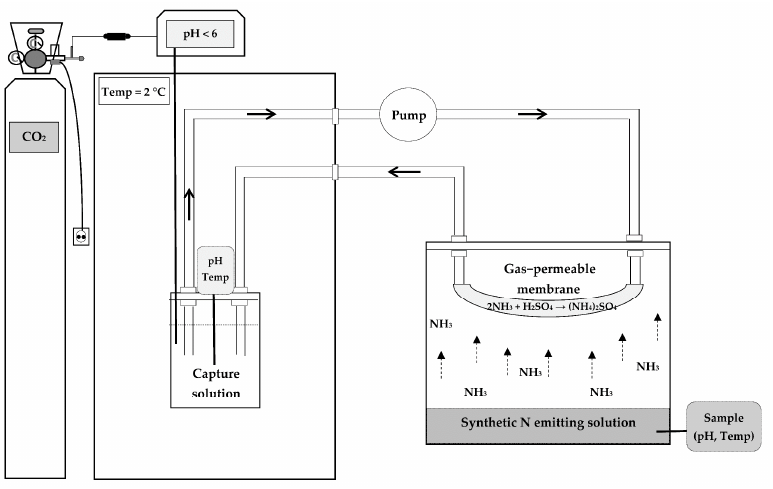
Figure 2. Diagram of the NH 3 capture process with different ammonia capture solutions.